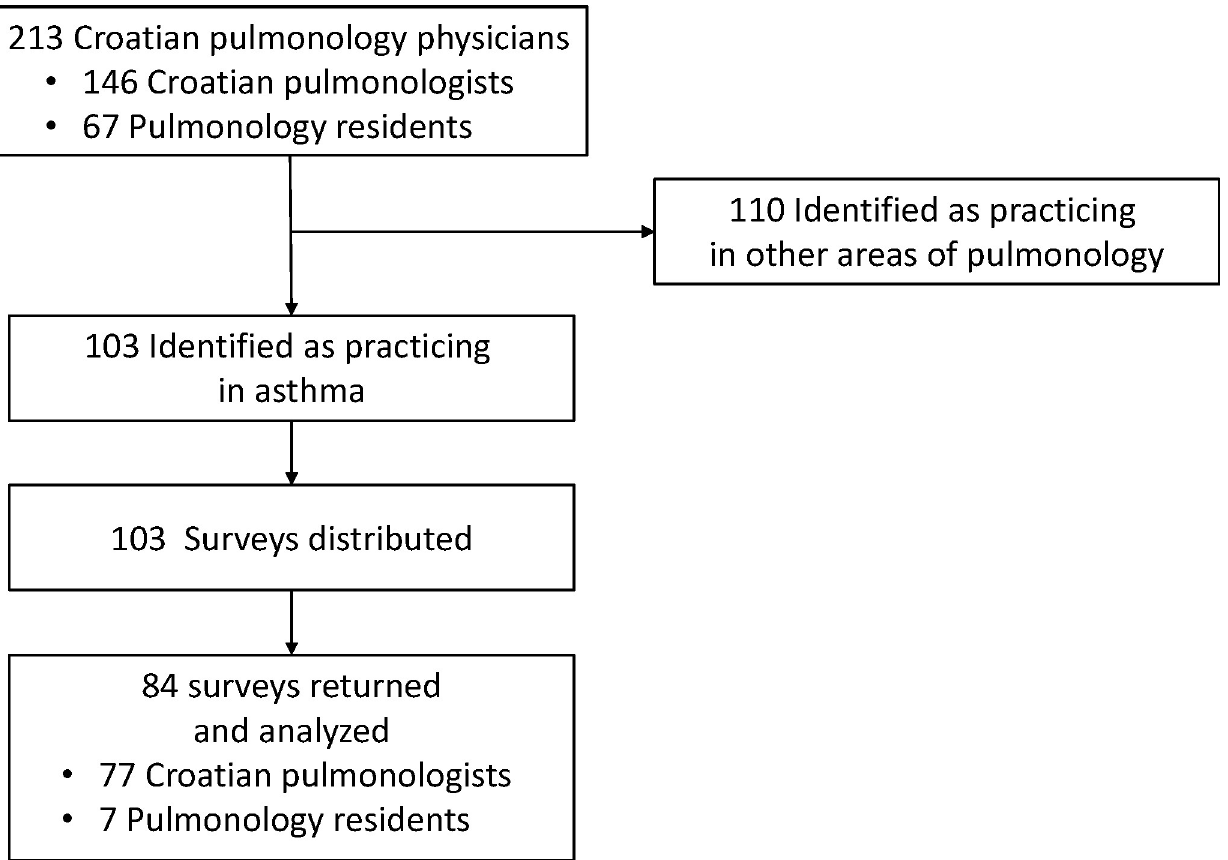
Fig 1. Flow of the participants through the